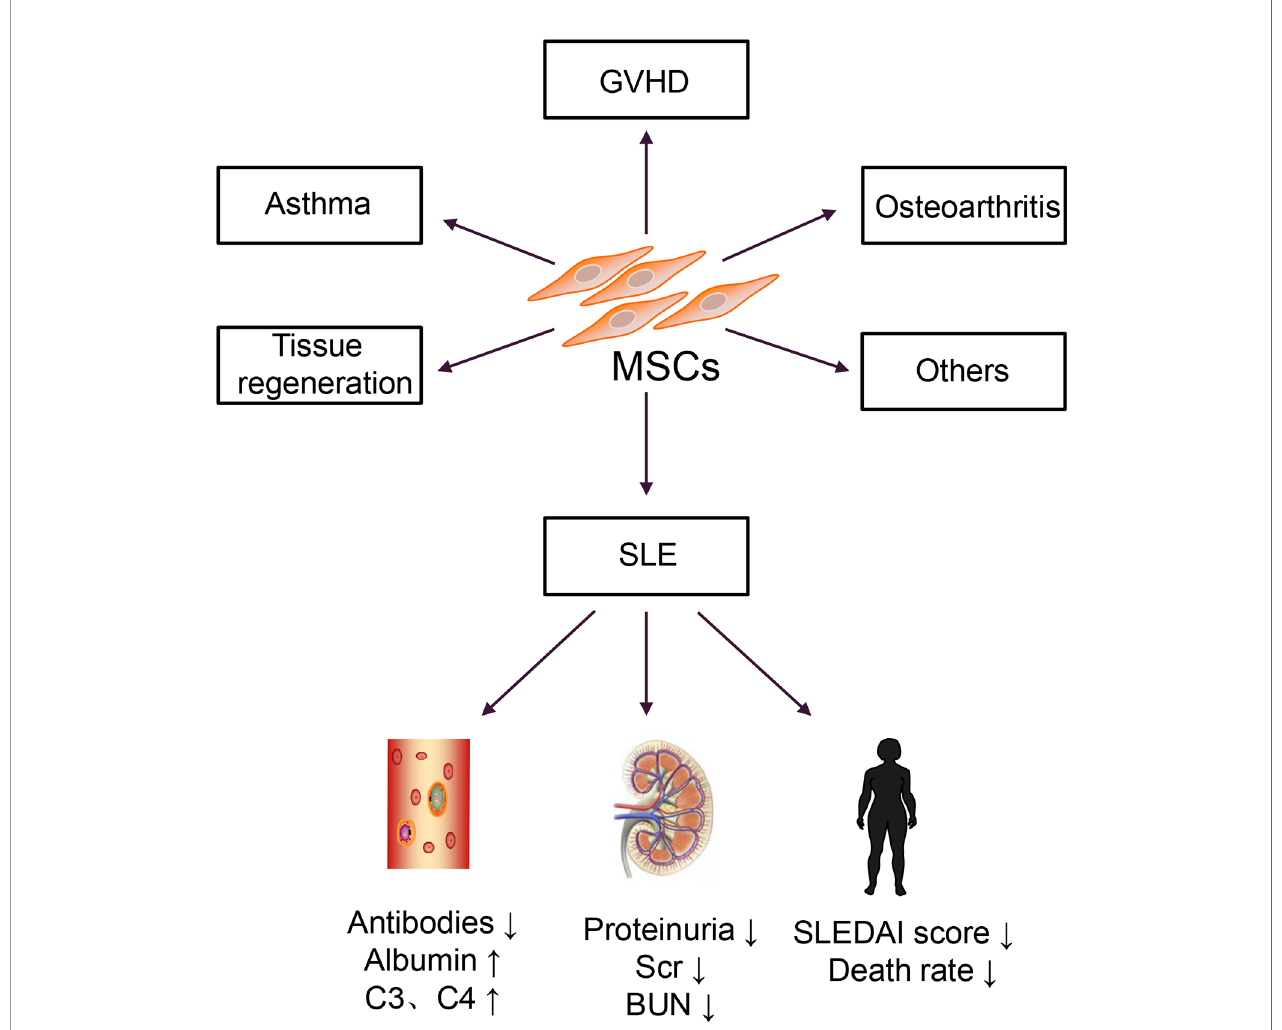
FIGURE 1 | Clinical applications of